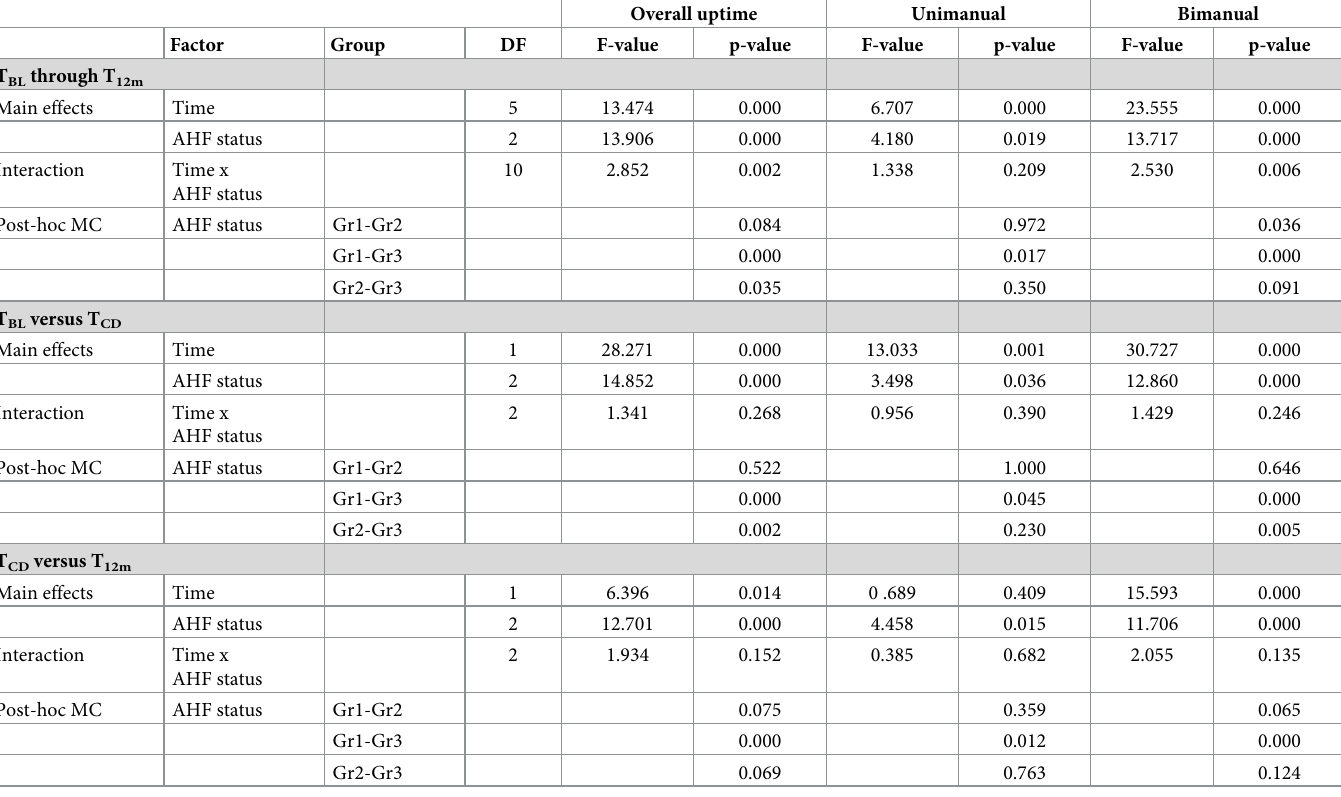
Table 2. Statistics regarding